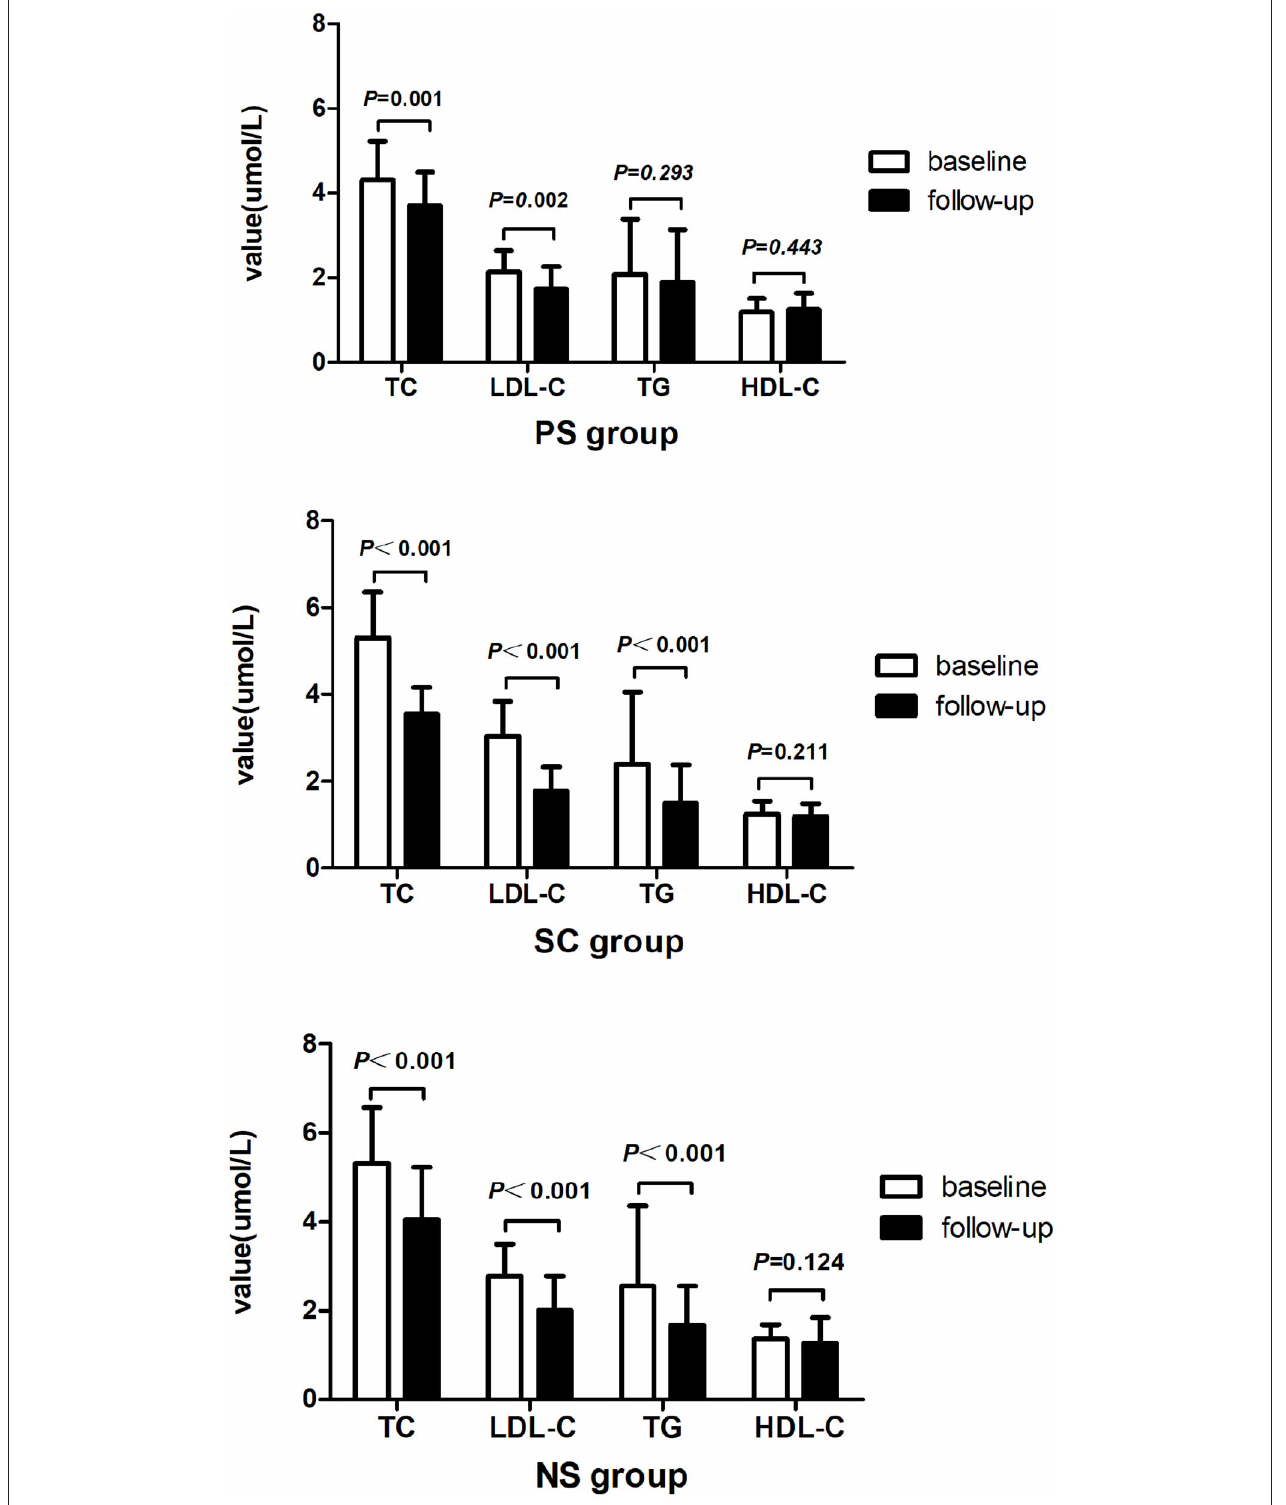
FIGURE 2 | Changes in cholesterol level in each group observed after 1 year. TC and LDL-C levels decreased in all three groups after 1 year of statin therapy. TG level significantly decreased in the SC and NS groups, but not in the PS group. TC, total cholesterol; LDL-C, low-density lipoprotein cholesterol; TG, triglyceride; HDL-C, high-density lipoprotein